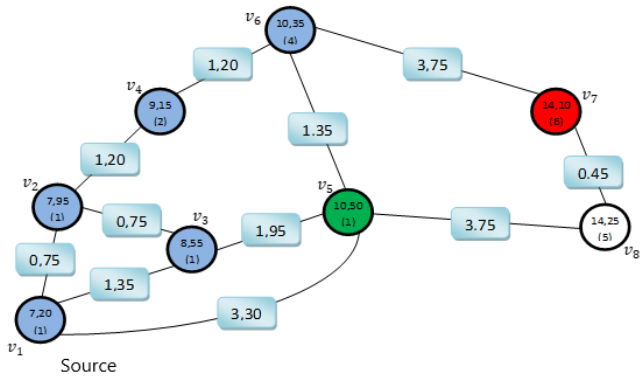
Figure 9. Finding the optimal path from peak 1—step 6.